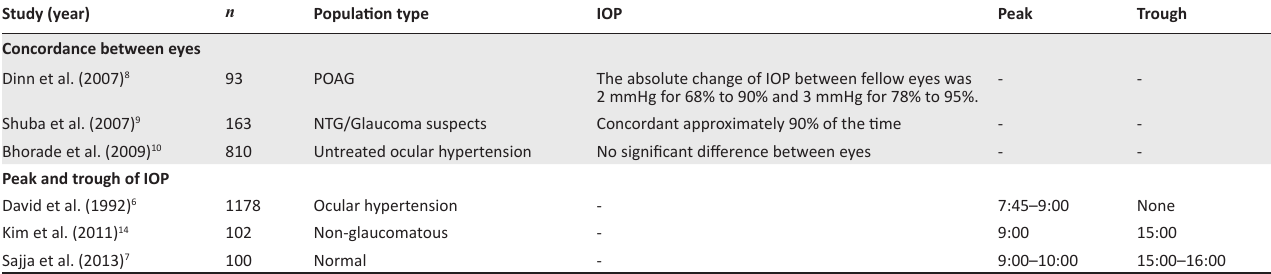
TABLE 1: Intraocular pressure patterns of behaviour in glaucomatous and non-glaucomatous eyes. Study (year) n Population type IOP Concordance between eyes Dinn et al. (2007) 8 93